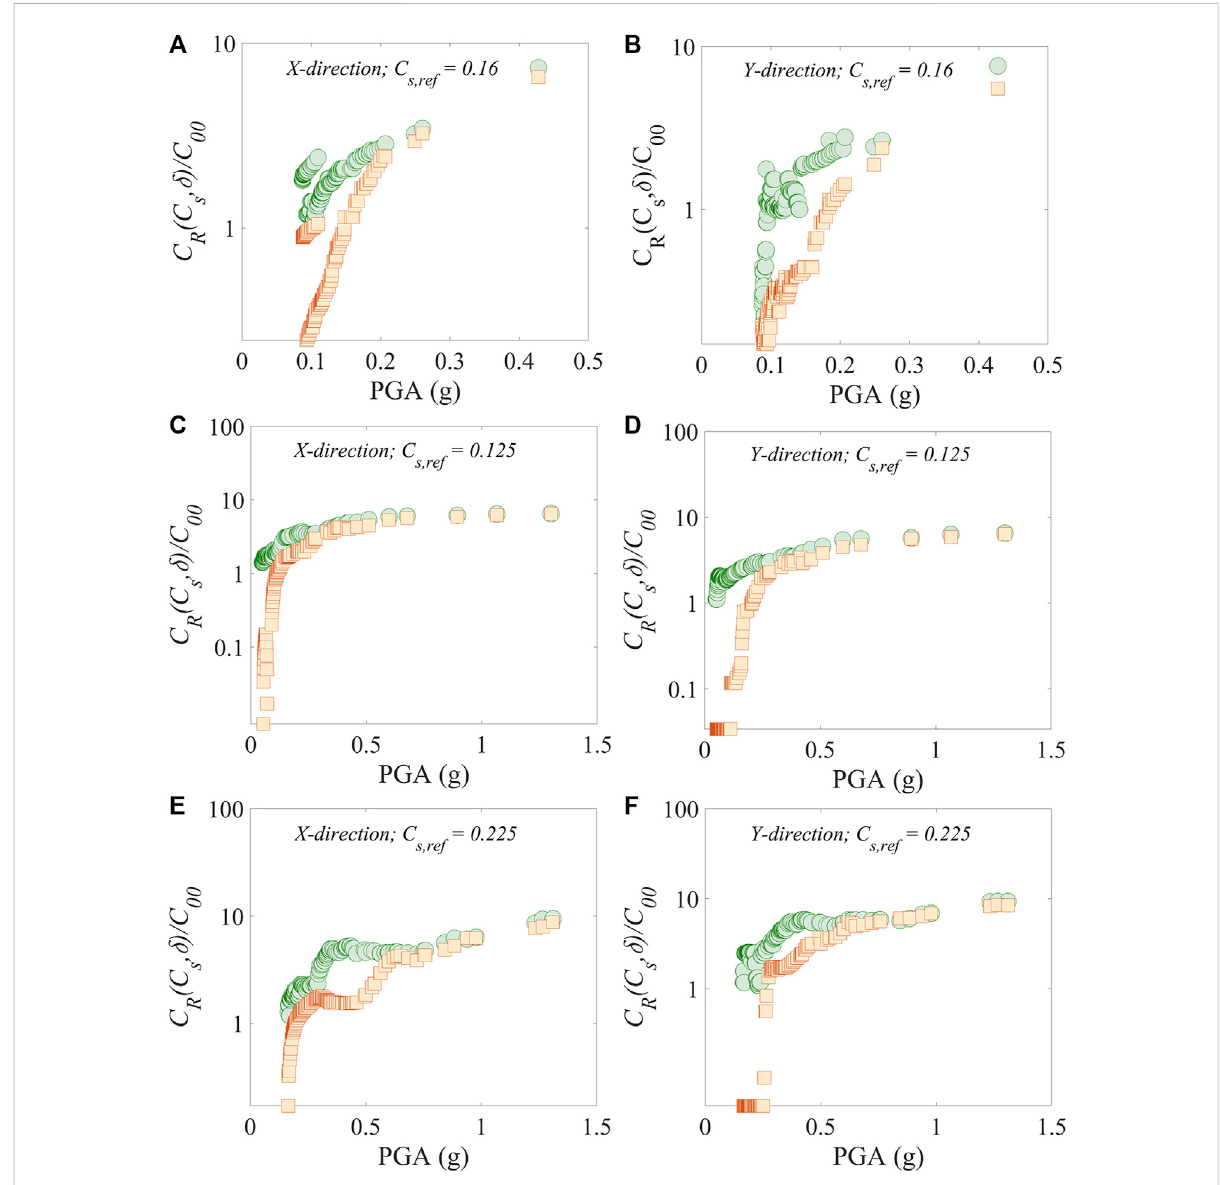
FIGURE 8 C R ( C s | δ ) fortheRCbuildingswithoutandwithNLVDs: (A,B) RCbuildinglocatedinMexicoCity; (C,D) RCbuildinglocatedinPuebla;and (E,F) RC building located in the coast of Guerrero. Circles denote RC buildings without NLVDs and squares RC buildings with